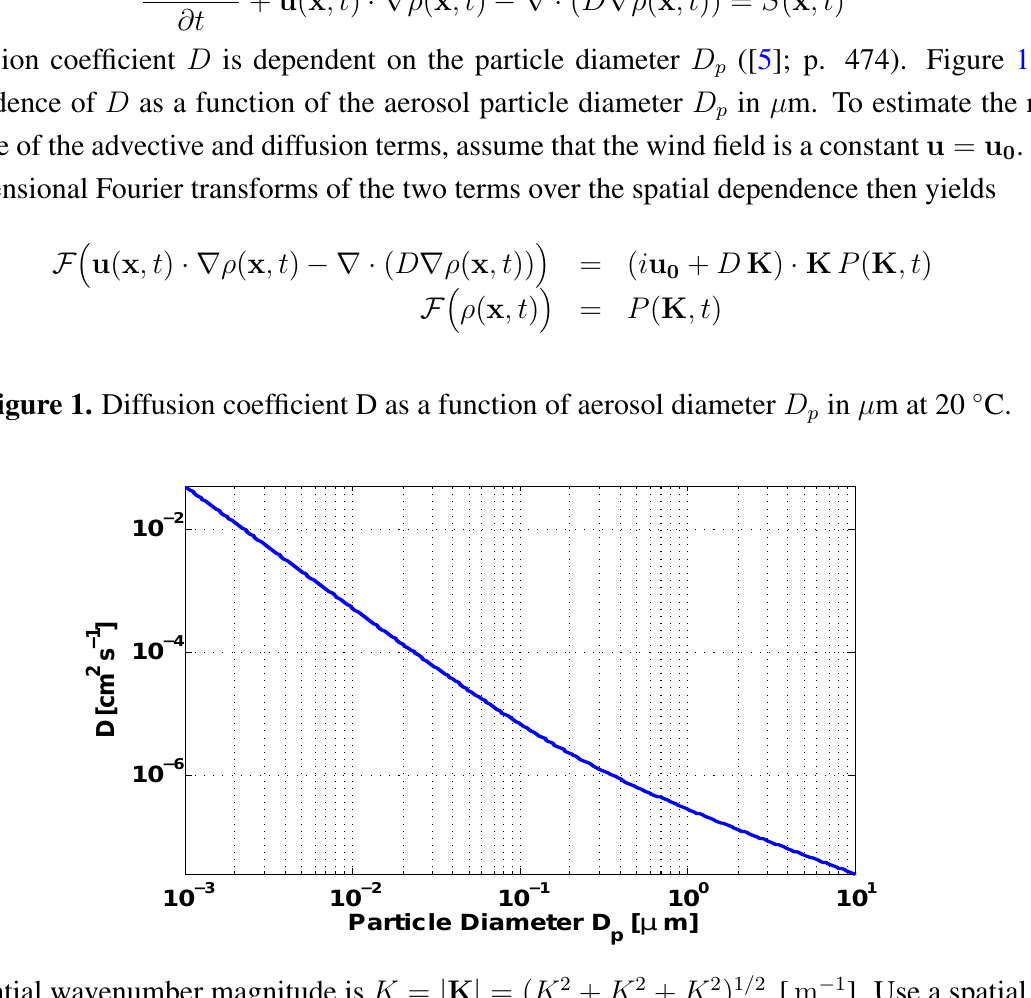
Figure 1. Diffusion coefficient D as a function of aerosol diameter D